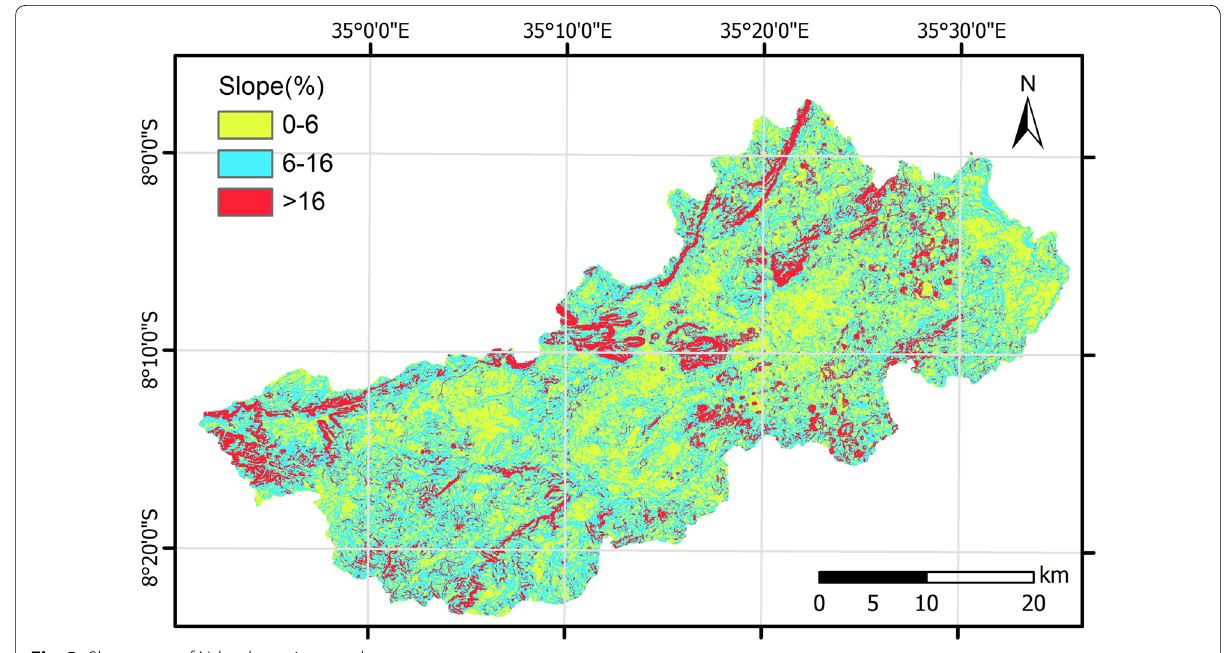
Fig. 3 Slope map of Ndembera river catchment